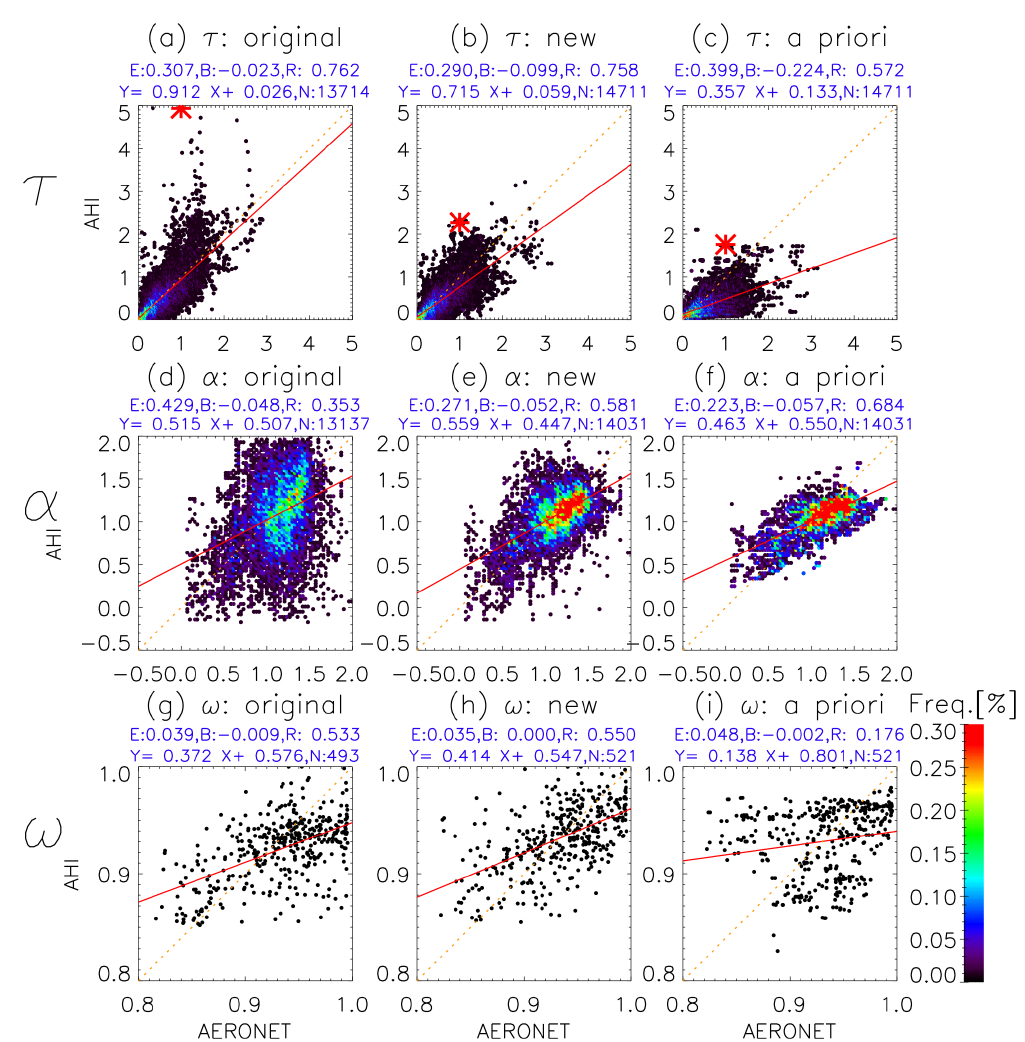
Figure 6. Frequency distribution of τ (a, b, c) , α (d, e, f) , and ω (g, h, i) retrieved from AHI and those from AERONET. Panels (a) , (d) , and (g) show the results from the original algorithm (i.e., using constant a priori), (b) , (e) , and (h) show the results from this algorithm, and (c) , (f) , and (i) are an a priori estimate used for (b) , (e) , and (h) , respectively. E , B , R , and N above the figures show the root mean square error, mean bias, correlation, and total number, respectively. Red asterisks in (a) , (b) , and (c) indicate the results at the red circles in Fig. 7a and b.